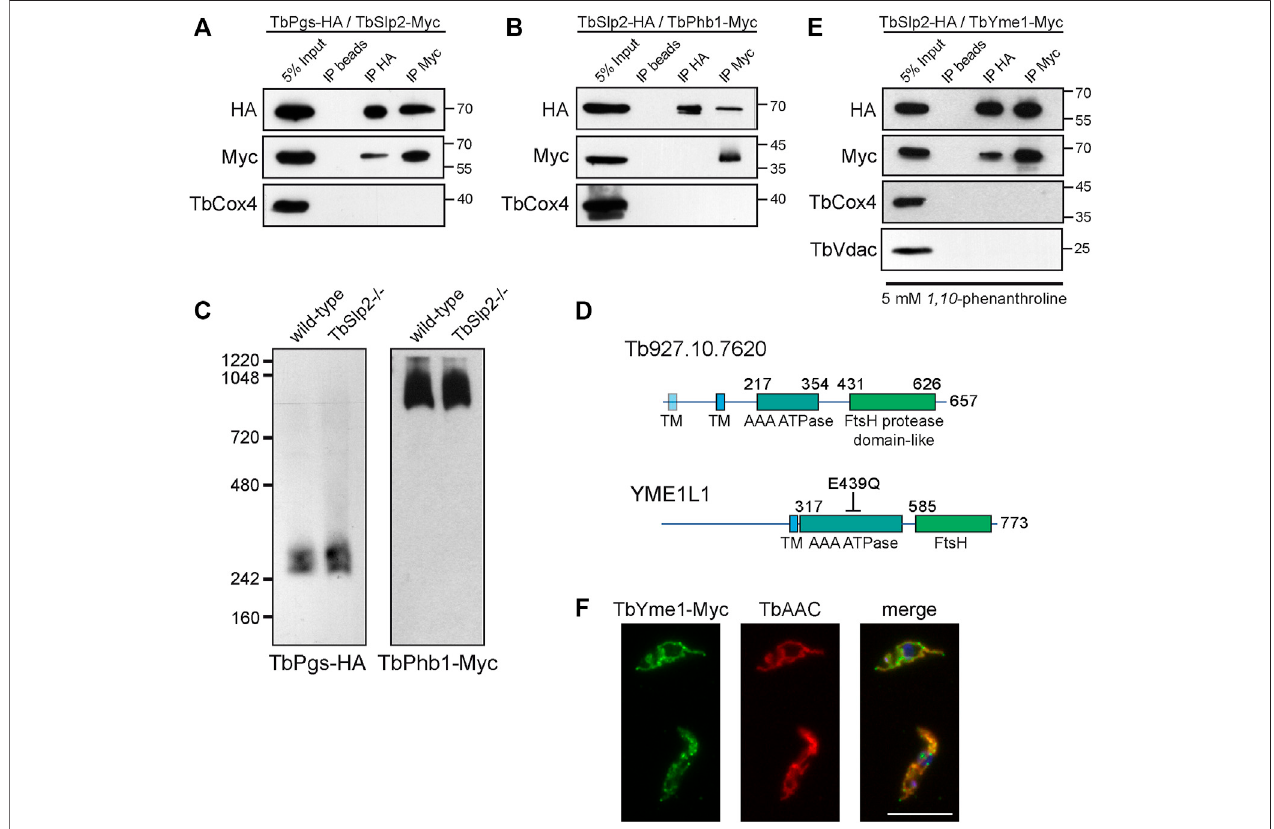
FIGURE2| TbSlp2 interactswiththe AAA-ATPaseTbYme1. (A) Co-expressedTbSlp2-Mycand TbPgs-HAwere immunoprecipitated withHAor Myc antibodies, or with beads alone, and analyzed by SDS-PAGE and immunoblotting. (B) Co-expressed TbSlp2-Myc and TbPhb1-HA were immunoprecipitated with HA or Myc antibodies,orbeadsalone,andanalyzedbyimmunoblotting.TbCox4servedasacontrolproteinthatshouldnotco-purify. (C) TbPgs-HA (leftpanel) andTbPhb1-Myc (right panel) expressed in wild-type or TbSlp2 − / − parasites were analyzed by native PAGE and immunoblotting using HA or Myc antibodies. (D) Schematic representation of the domain structure of uncharacterized protein Tb927.10.7620 in comparison to human YME1L1. The mutation E439Q in the ATPase domain of human YME1L1 leads to loss of ATPase activity. The fi rst transmembrane domain (TM) in Tb927.10.7620 was identi fi ed experimentally by (Kovalinka et al., 2020). (E) TbSlp2-HA co-expressed with TbYme1-Myc were immunoprecipitated using beads alone or HA and Myc antibodies in the presence of 5 mM 1, 10-phenanthroline. Proteins were separated by SDS-PAGE and analyzed by immunoblotting. TbCox4 and TbVdac were used as to control for unspeci fi c binding. (F) The